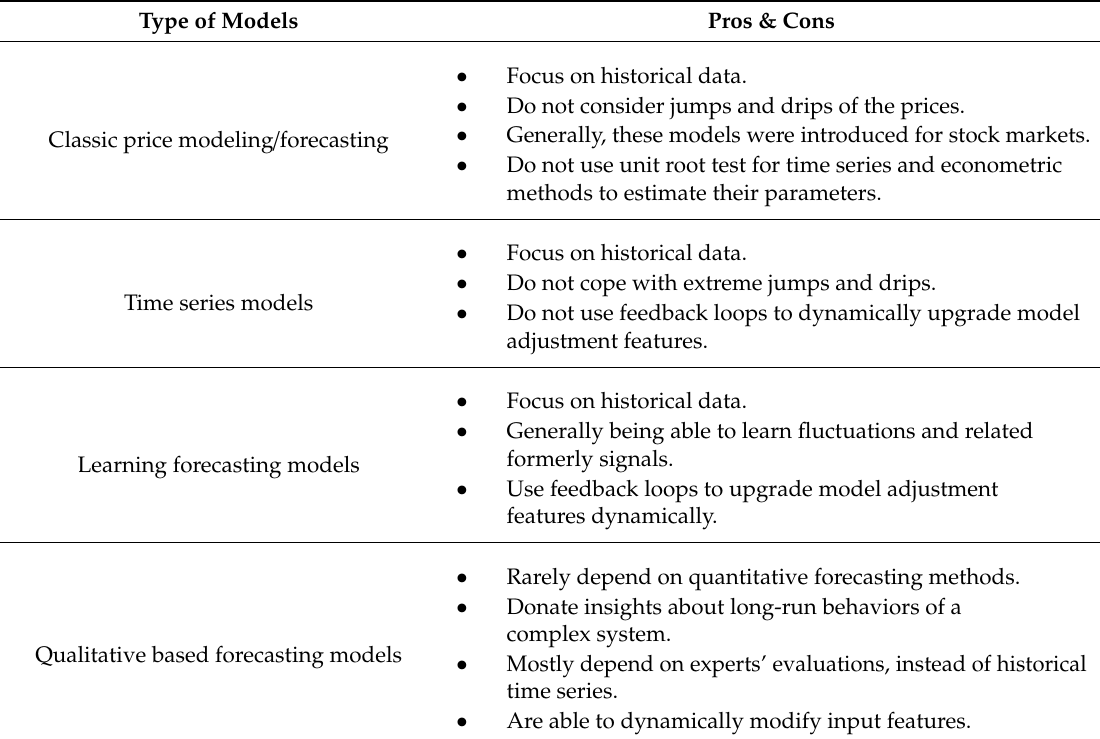
Table 2. The major pros and cons of main forecasting